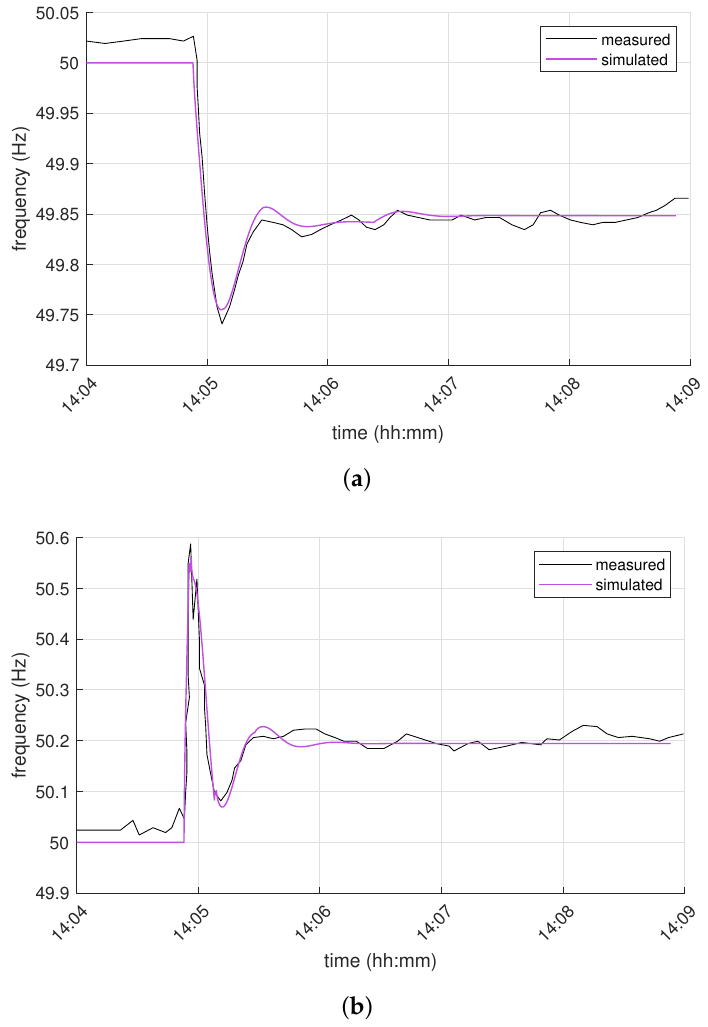
Figure 11. Comparison of simulation results with power imbalances and defensive actions distributed during the transient: ( a ) frequency in North-West part; ( b ) frequency in South-East